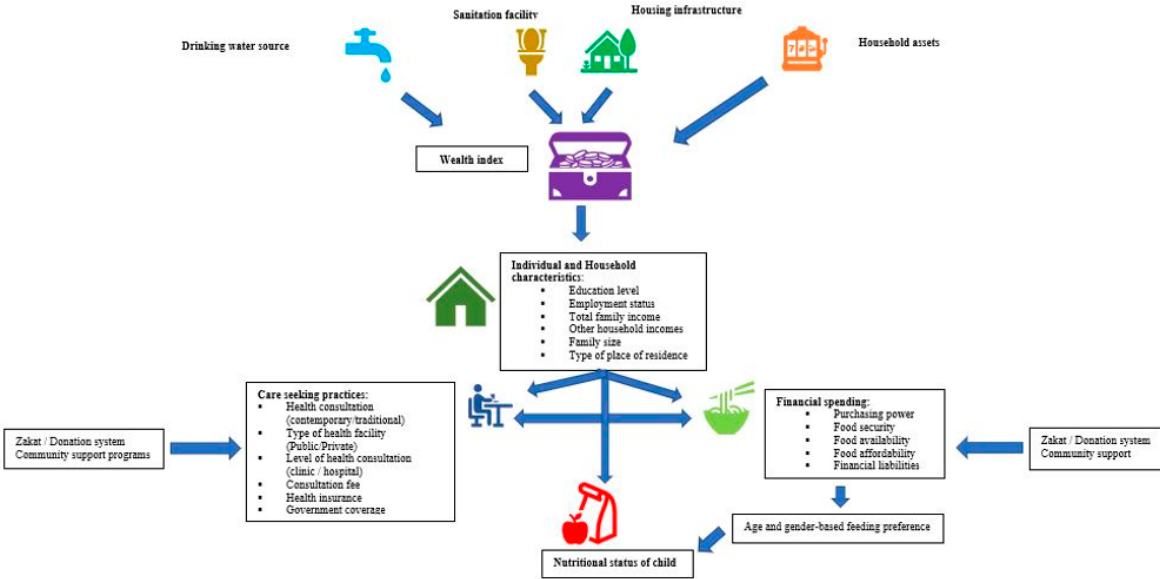
Figure 2. Conceptual framework defining the relationship of pediatric malnutrition with socioeconomic status and related factors.